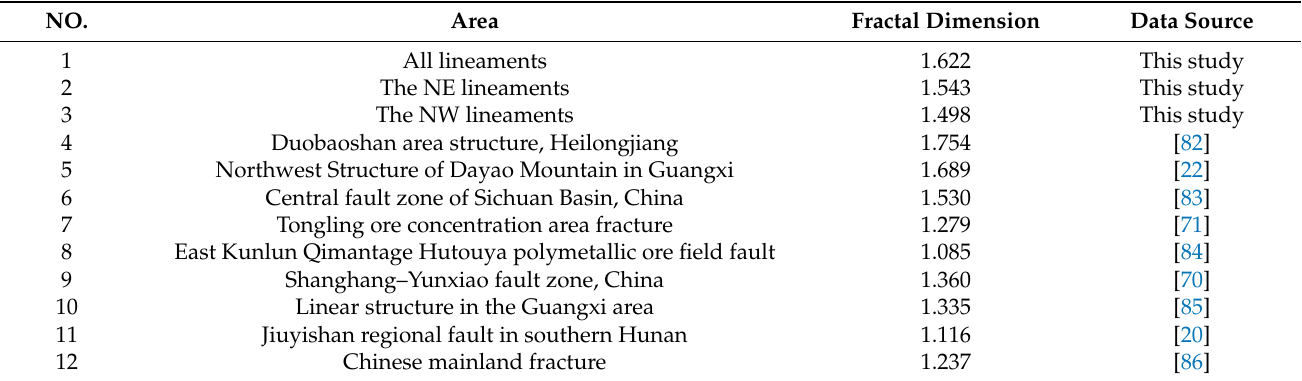
Table 2. Comparison of fractal characteristics with other